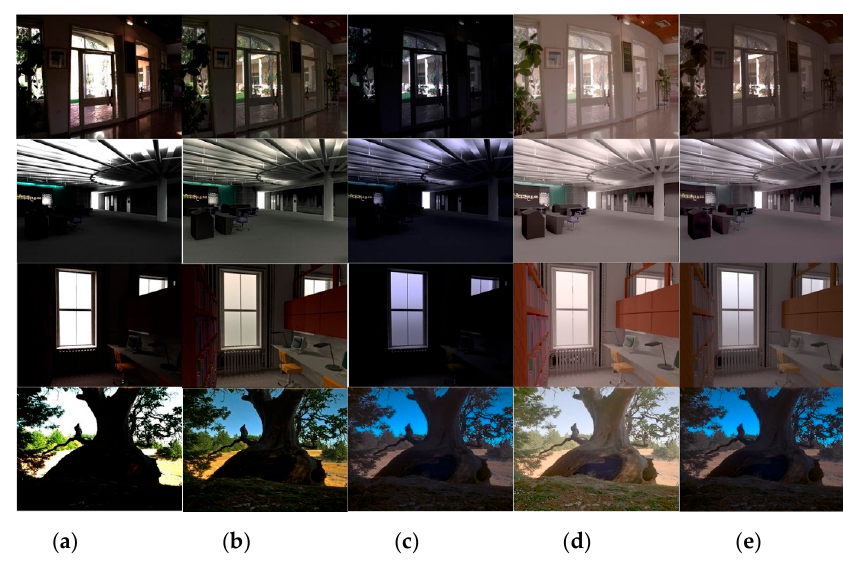
Figure 7. Other images with ( a ) an original HDRI and resulting images of ( b ) iCAM06, ( c ) Reinhard’s method, ( d ) Choi’s method, and ( e ) the proposed method.